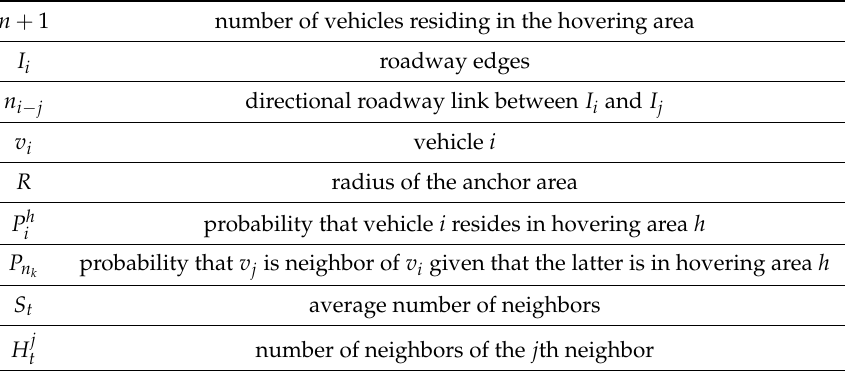
Figure 8. Road topology of the model used to relate analytically the vehicle density vs. the average number of neighbors. Table 2. Significant Notation for the Density Estimation